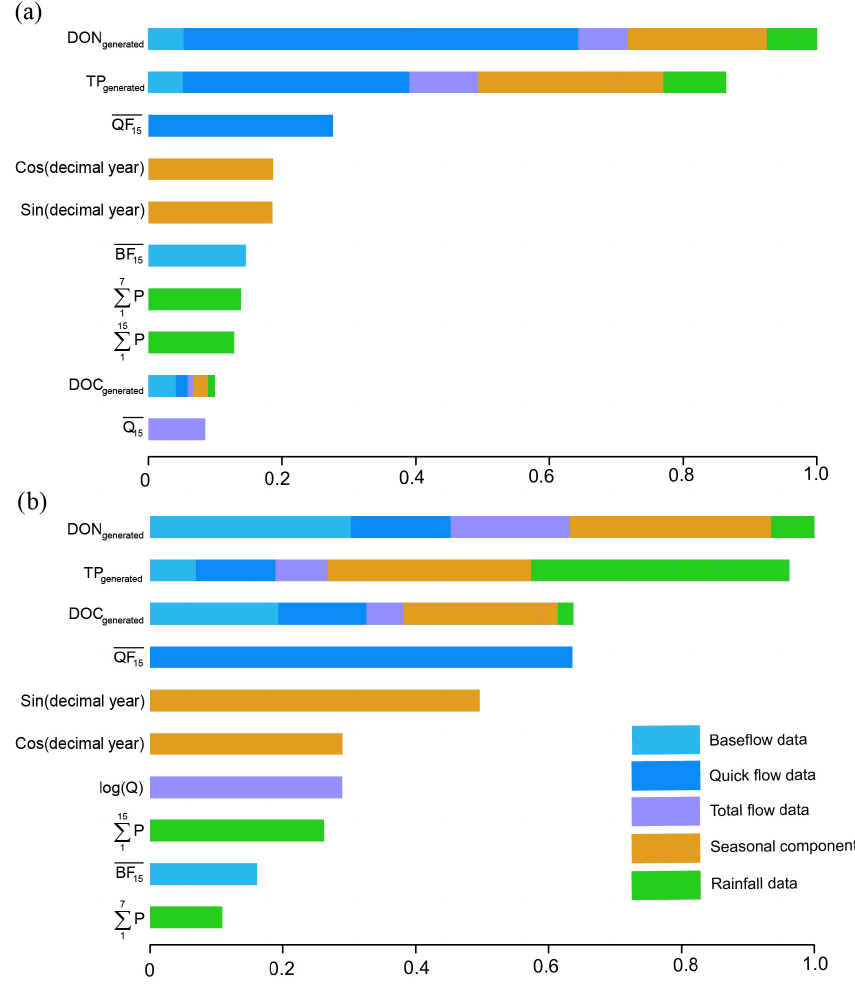
Figure 6. Variable importance in the hybrid GBM for TN prediction in (a) Ellen Brook and (b) Murray